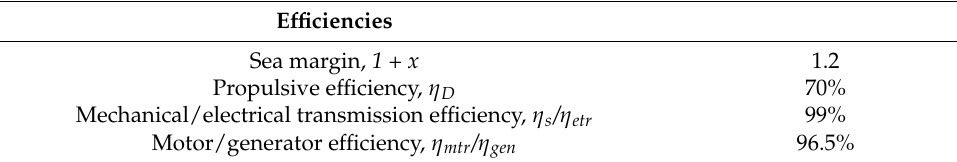
Table 6. Assumed values of efficiencies.